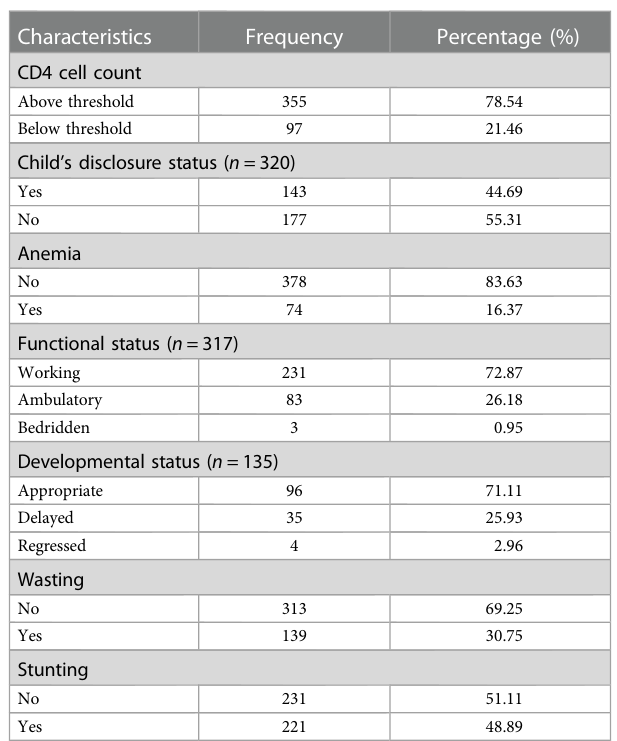
TABLE 3 Baseline clinical, nutritional, and laboratory test characteristics of HIV-infected children receiving ART at Amhara regional state comprehensive specialized hospitals, Ethiopia,